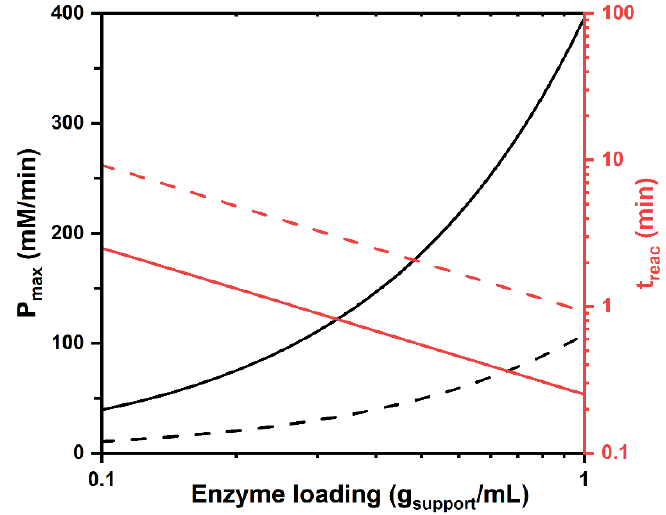
Figure 6. Analysis of the reactor productivity upon variation of catalyst loading and operation temperature. Temperatures: 23.5 ◦ C (solid line) and 50 ◦ C (dashed line). The black line shows the maximum productivity of the immobilized enzyme and the red line shows the time of the reaction. These results were simulated using the kinetics constants obtained for the free enzyme (Table S2, Supplementary Materials) and V max measured for the Ag-Gly 2000 U _pNPG /g support .